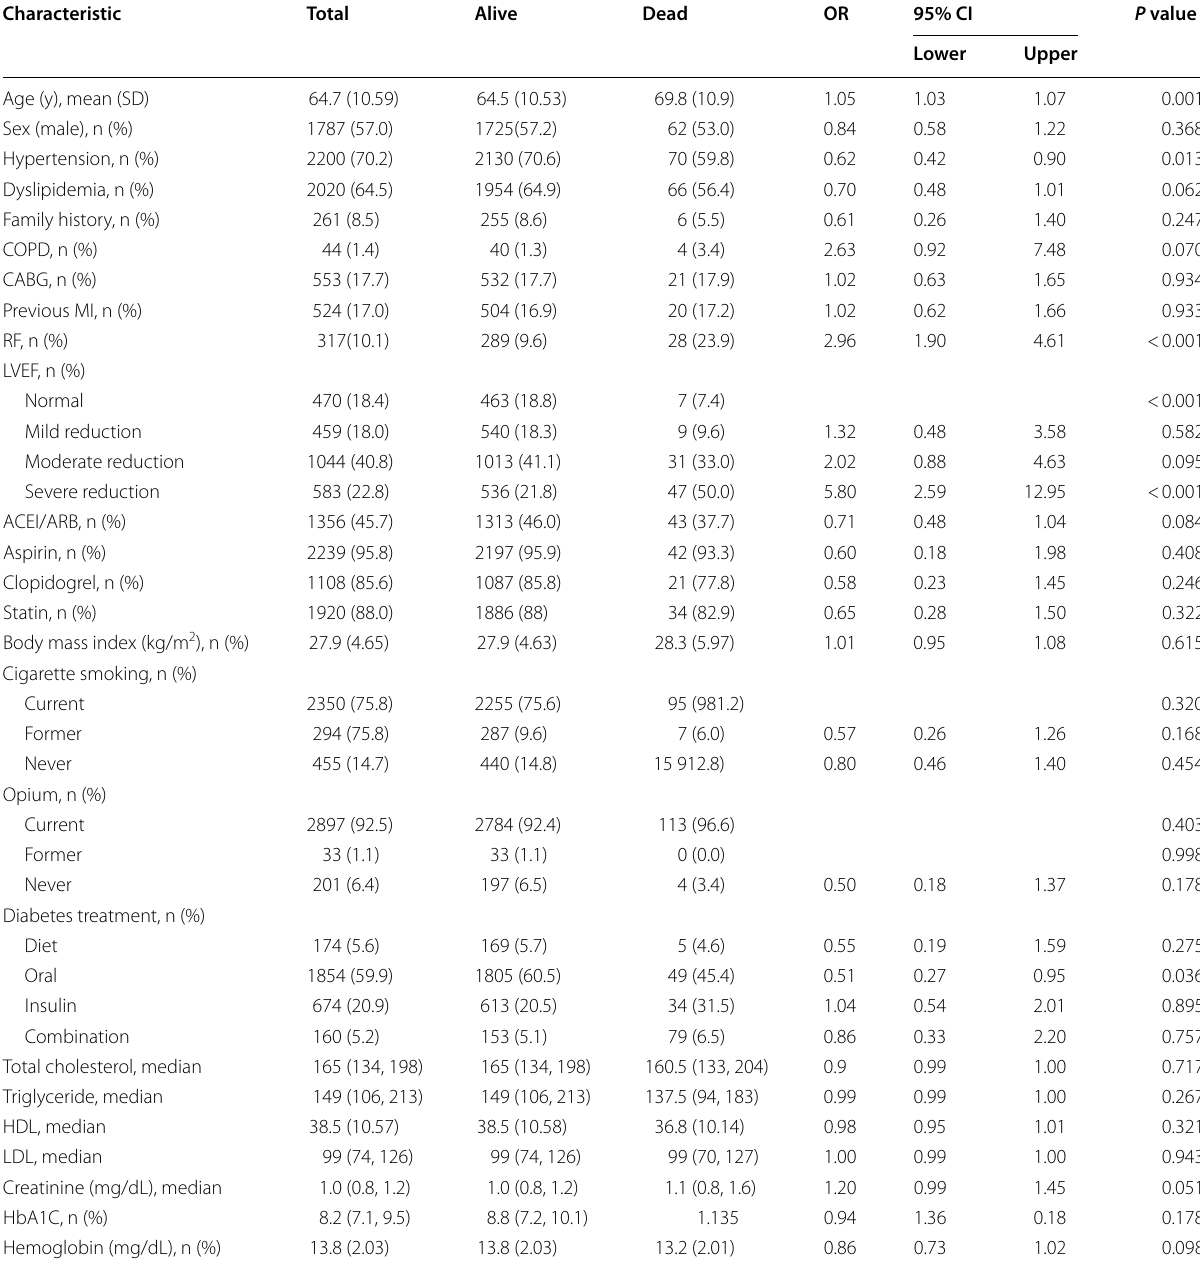
Continuous variables are presented as the mean (SD) or the median (25th and 75th percentiles) Categorical variables are described as frequencies (percentages); n (%) COPD chronic obstructive pulmonary disease, CABG coronary artery bypass graft, MI myocardial infarction, RF renal failure, LVEF left ventricular ejection fraction, ACEI angiotensin-converting enzyme inhibitor, ARB angiotensin II receptor blocker, HDL high-density lipoprotein, LDL low-density